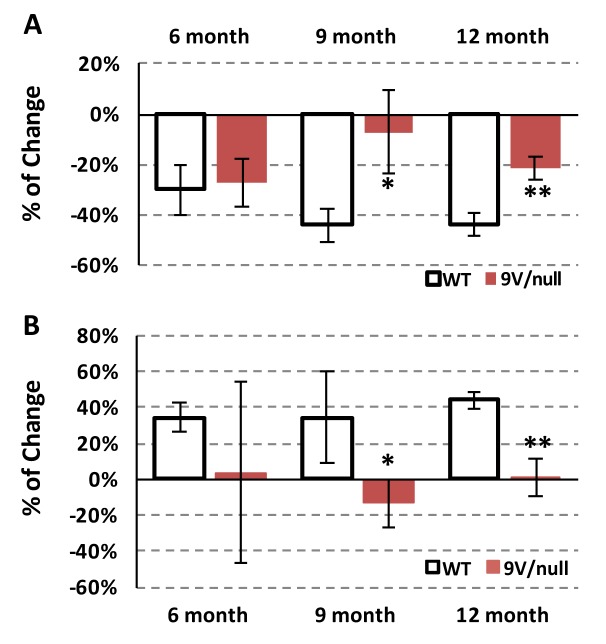
Short-term memory deficits in 9V/null mice evaluated by repeated open-field test.Each mouse was allowed to freely explore the arena for three trials with 5 min each and 30-min intervals. Exploring activities in the third trial were compared to the second trial presented as percentage for change of horizontal activity (A) and time spent grooming (B). 9V/null mice showed significantly less habituation in exploring horizontal activity and reduced grooming time at 9 and 12 months of age. *, p<0.05; **, p<0.01 (n = 9–35 mice per age group) by Student’s t-test.